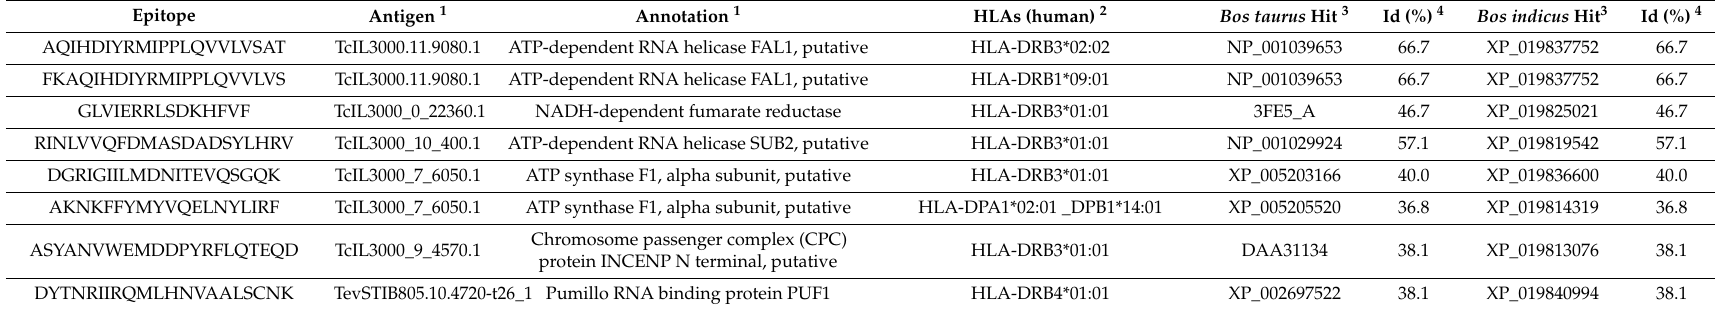
Table 2. List of the CD4 T-cell epitopes predicted in the invariant AAT-spp. proteome that were selected for the